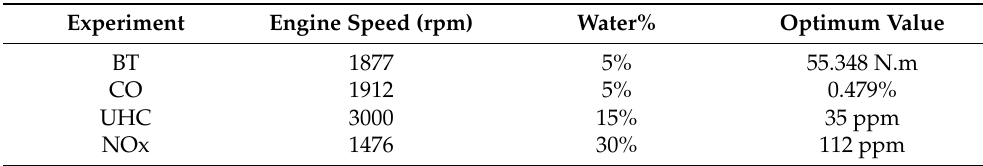
Table 8. Outcomes of the optimization process for each response in relation to the volume of water in the fuel mixture.